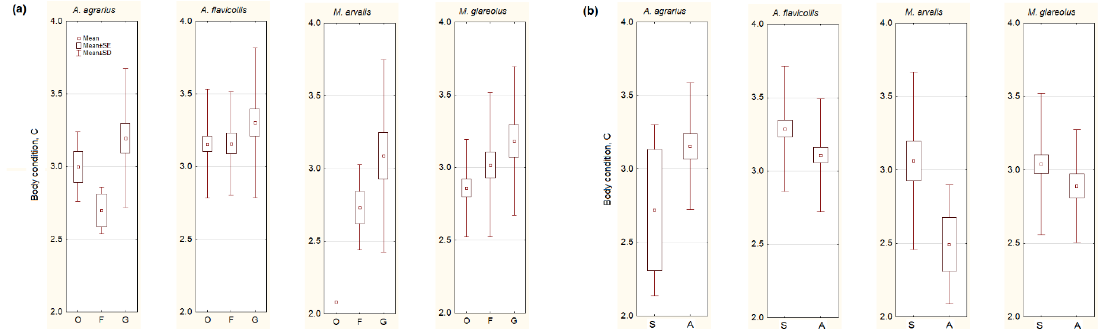
Figure 3. Body condition of the most numerous small mammals depending on the habitat ( a ): G represents garden habitats, F—buildings where food for animals is available, O—outbuildings, not related to food sources, and on season ( b ): S—summer, A—autumn. Central point shows average values, box—SE, whiskers—SD.